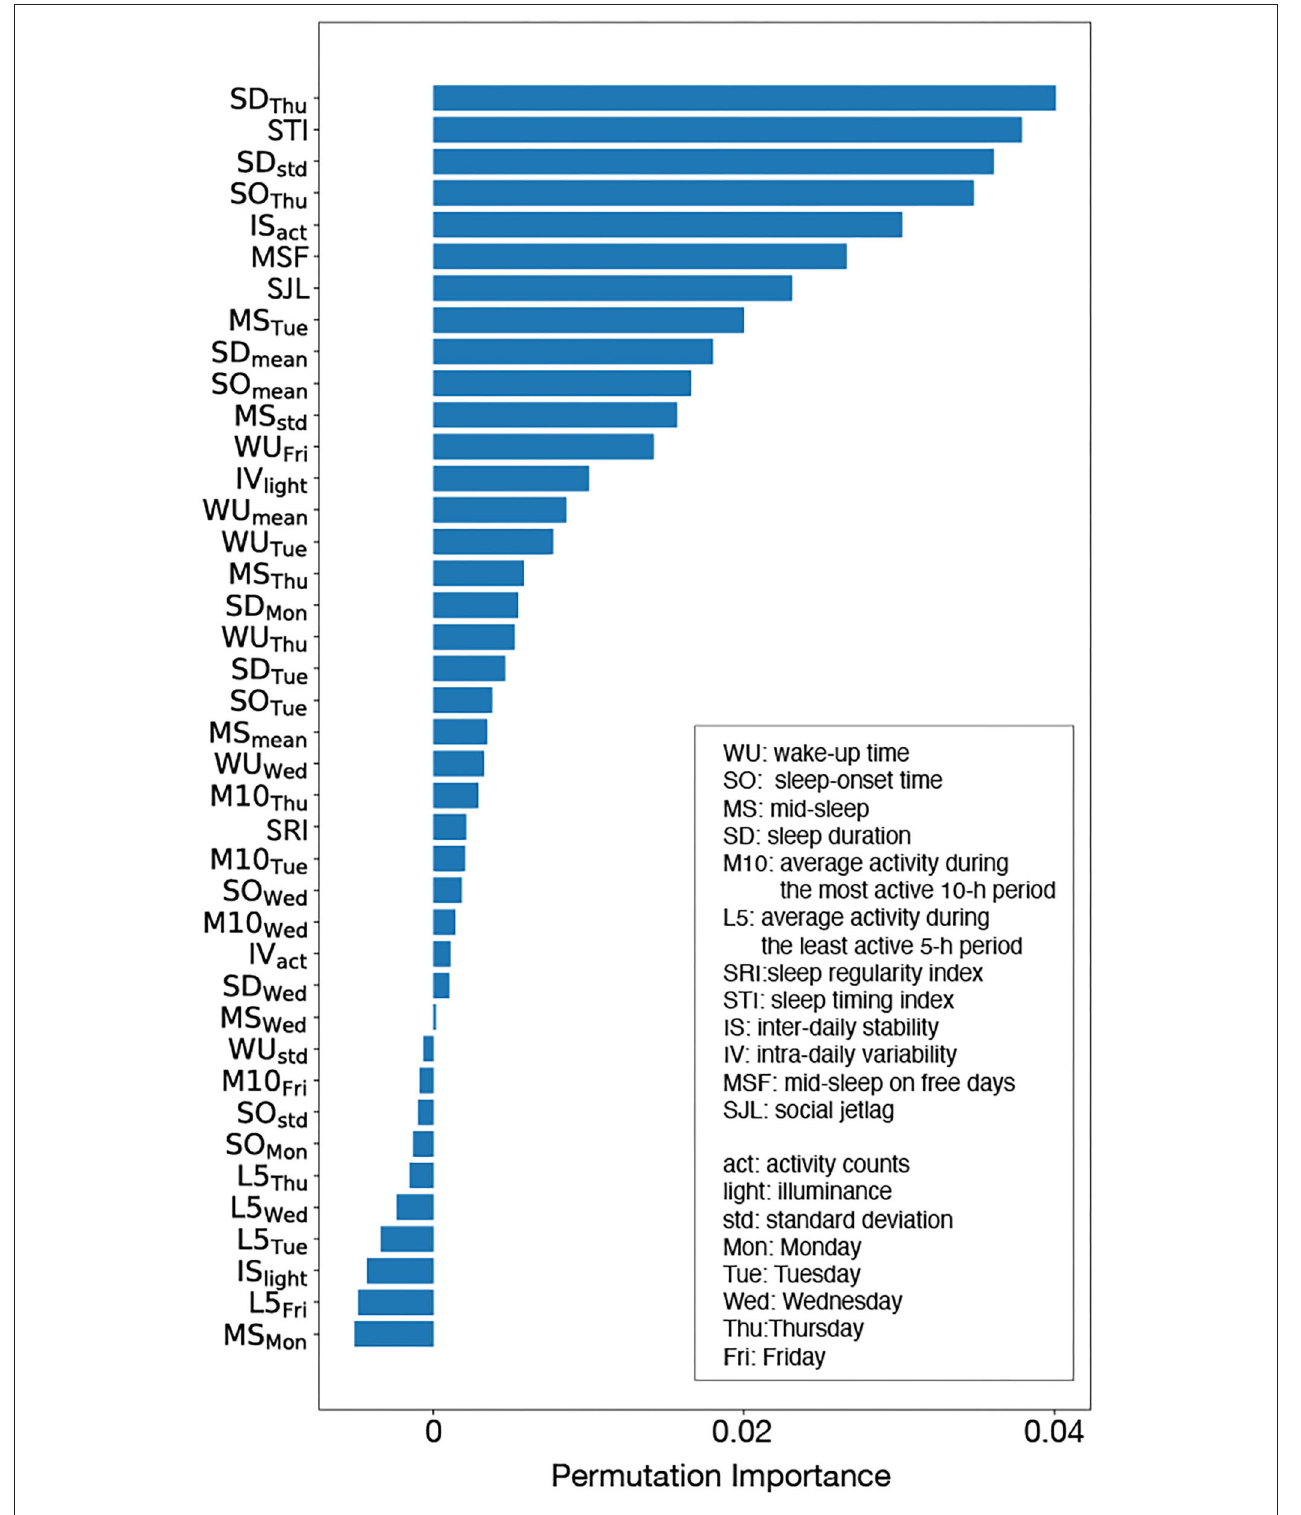
FIGURE 5 | Permutation importance: although there were some features with negative importance, such features did not contribute to WSD prediction. Sleep duration on Tuesday (SD Thu ), sleep timing index (STI), the standard deviation of sleep duration (SD std ), sleep onset on Tuesday (SO Thu ), inter-daily stability calculated by the activity counts (IS act ), mid-sleep on free days (MSF), and social jetlag (SJL) were judged as the important features for WSD.